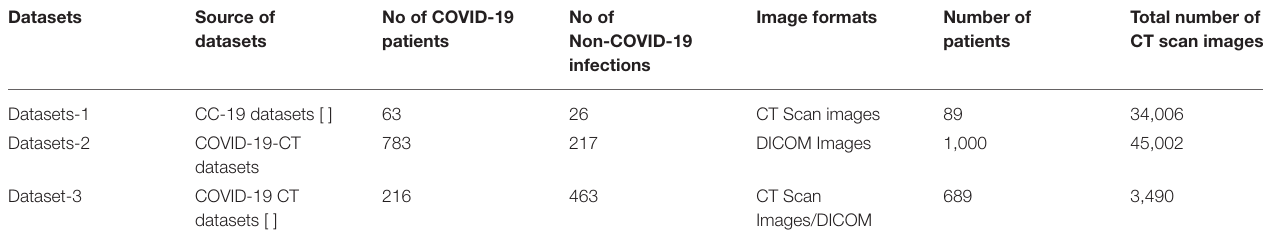
TABLE 1 | Summary of the dataset details used for the proposed